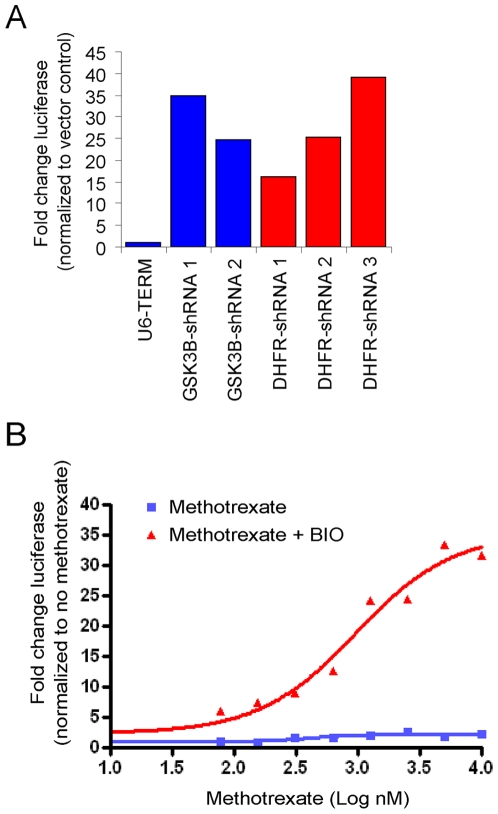
GSK3 inhibitor activity is enhanced by either DHFR silencing or inhibition by methotrexate.(A) Hit confirmation by the BAR assay. Fresh virus generated for DHFR shRNAs, GSK3β shRNAs, and empty vector controls was used to transduce RKO-BAR cells. 48 hours following transduction cells were exposed to a sub-optimal (non-activating) dose of GSK3i (312 nM) for another 24 hours before measuring pathway activation by luciferase activity. Importantly, all three vectors targeting DHFR (red bars) induced similar levels of activation as shRNAs targeting GSK3β. (B) Examination of the effect of the DHFR inhibitor methotrexate on BAR activation by BIO. RKO-BAR cells were exposed to a titration of methotrexate in the presence (red) or absence (blue) of a non-activating dose of BIO and luciferase activity was measured. In confirmation of the enhancement of BIO activity in cells transduced with shRNA targeting DHFR, inhibition by methotrexate is synergistic with GSK3 inhibition for activation BAR.